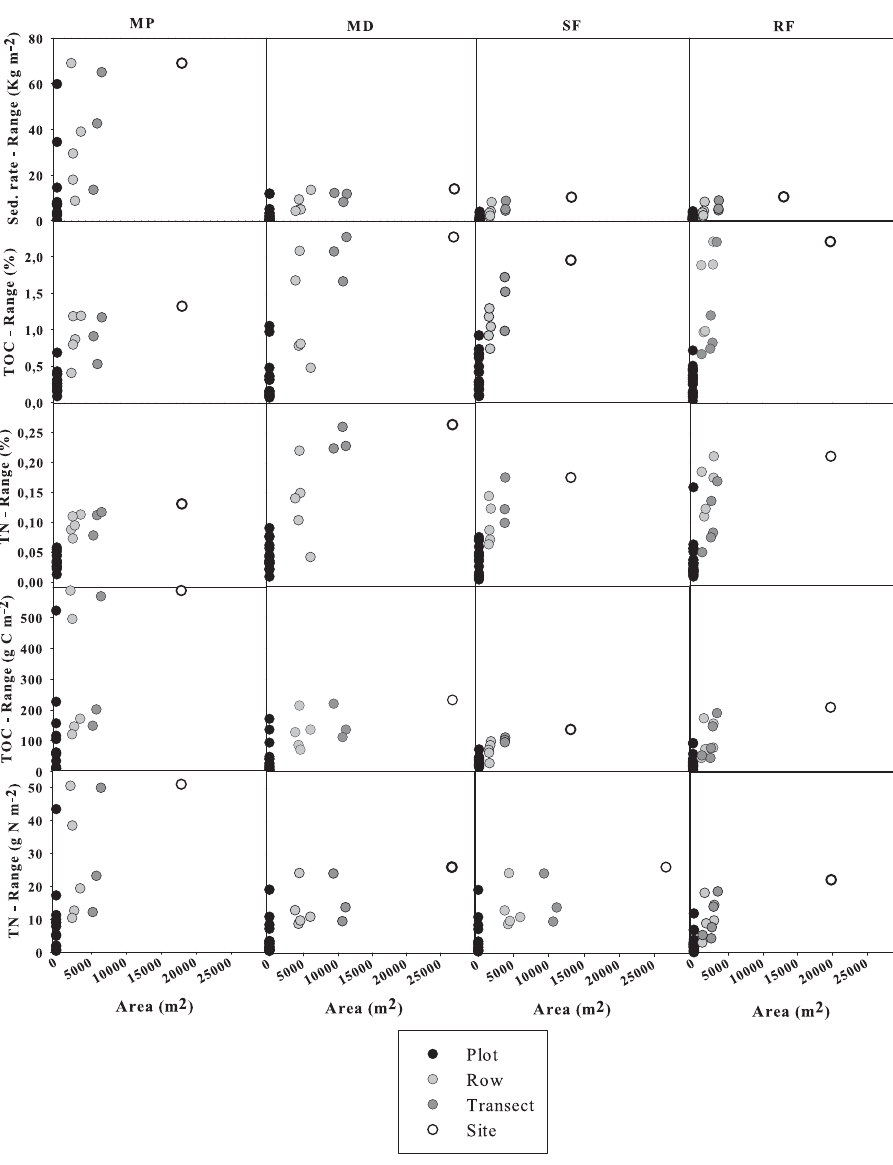
Fig. 4. TOC (%, gCm − 2 ), TN (%, gNm − 2 ) and sedimentation rates (kg/m2) ranges for different spatial scales (plot, transect, row and site). See methods for details on area